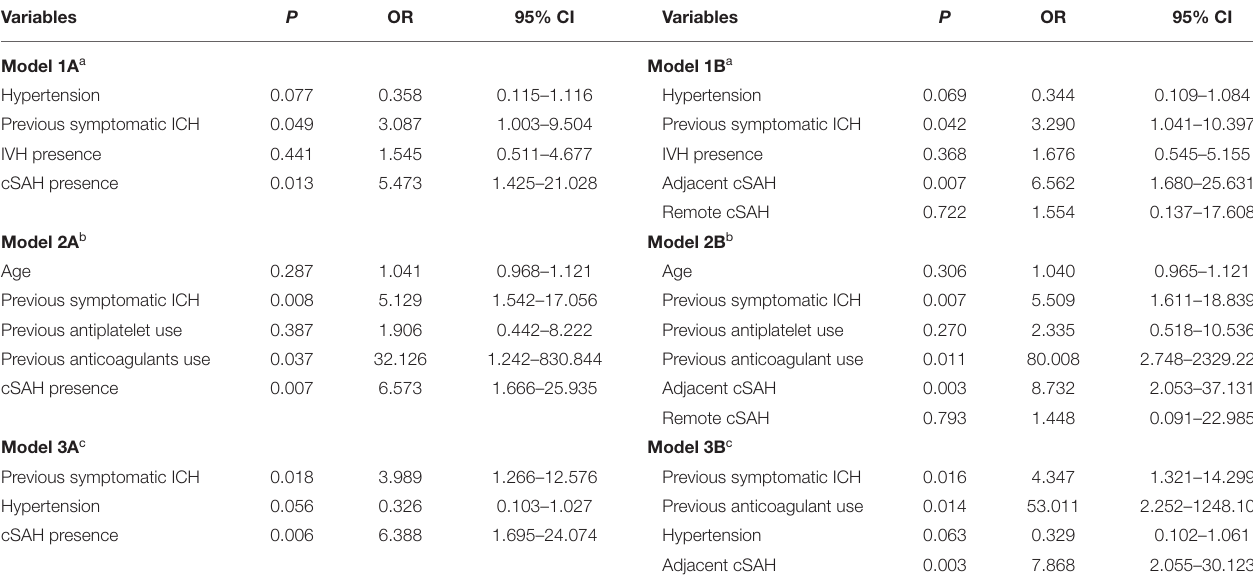
TABLE 5 | Multivariate regression analysis of predictors of ICH recurrence within 90 days. Variables P OR 95% CI Variables P